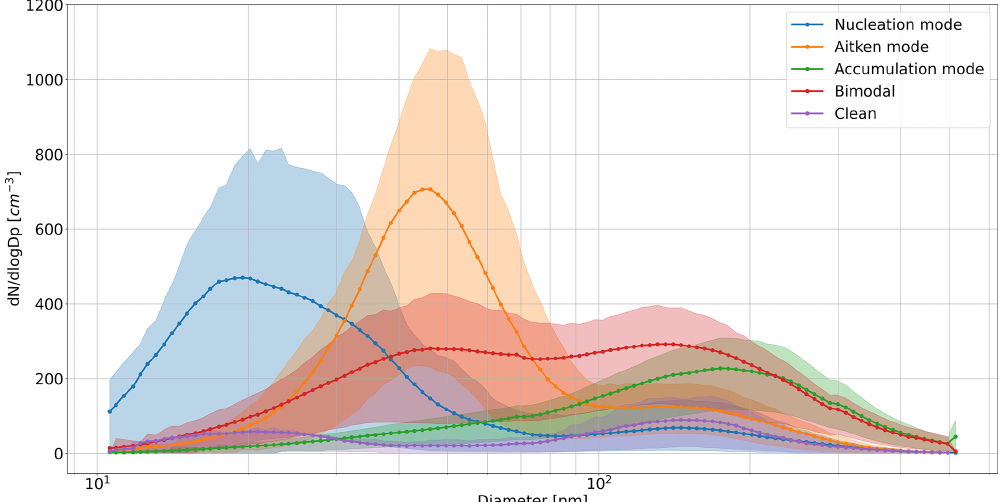
Figure 3. The average distributions of the PNSD clusters. The particle concentration in d N/ dlog D p is presented for the average of all days in each cluster according to the particle size. The shaded regions show the interquartile range associated with the PNSD data for each cluster type. Note that the nucleation- and accumulation-mode clusters presented here are the result of manually grouping the two nucleation-mode clusters and four accumulation-mode clusters into a single nucleation- and accumulation-mode cluster, respectively. Refer to Fig. S3 for the original nine-cluster output.